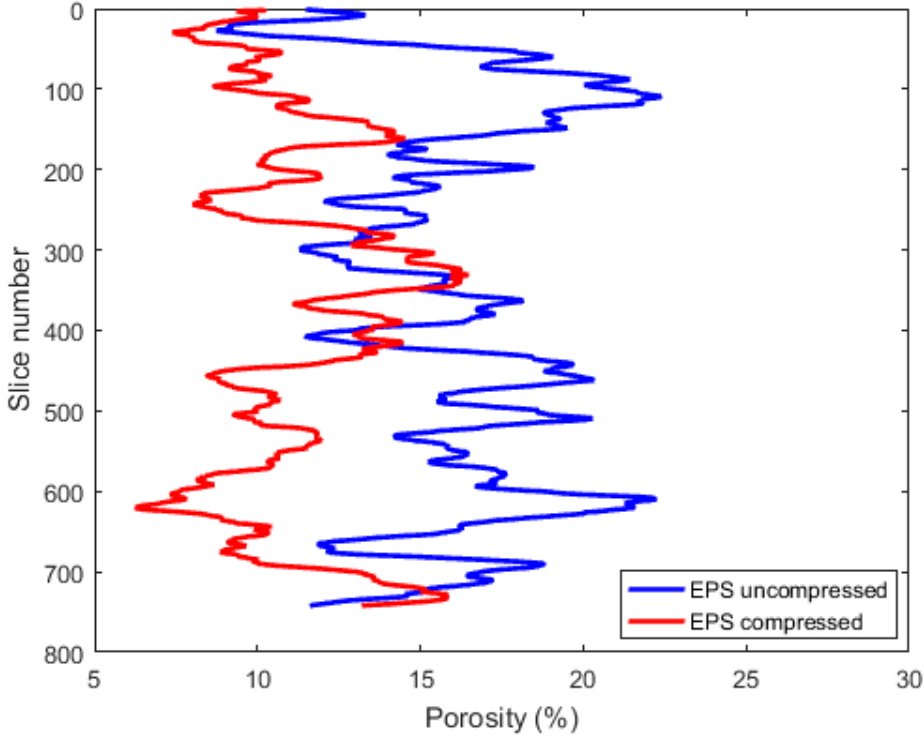
Figure 6. Porosity profile along the vertical direction; one slice had a thickness of 20 µm.